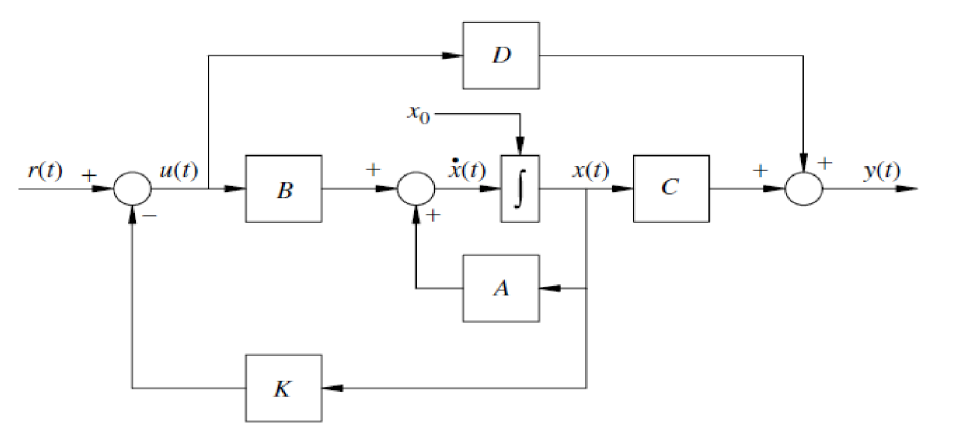
Figure 2. Closed-loop system block